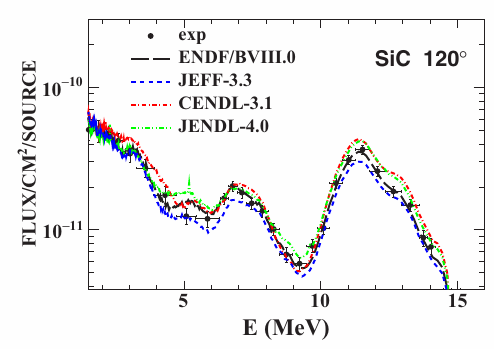
Figure 7. Neutron leakage spectra for SiC sample at 120 ◦ . Figure 2. Neutron leakage spectra for Ga sample at 60 ◦ .